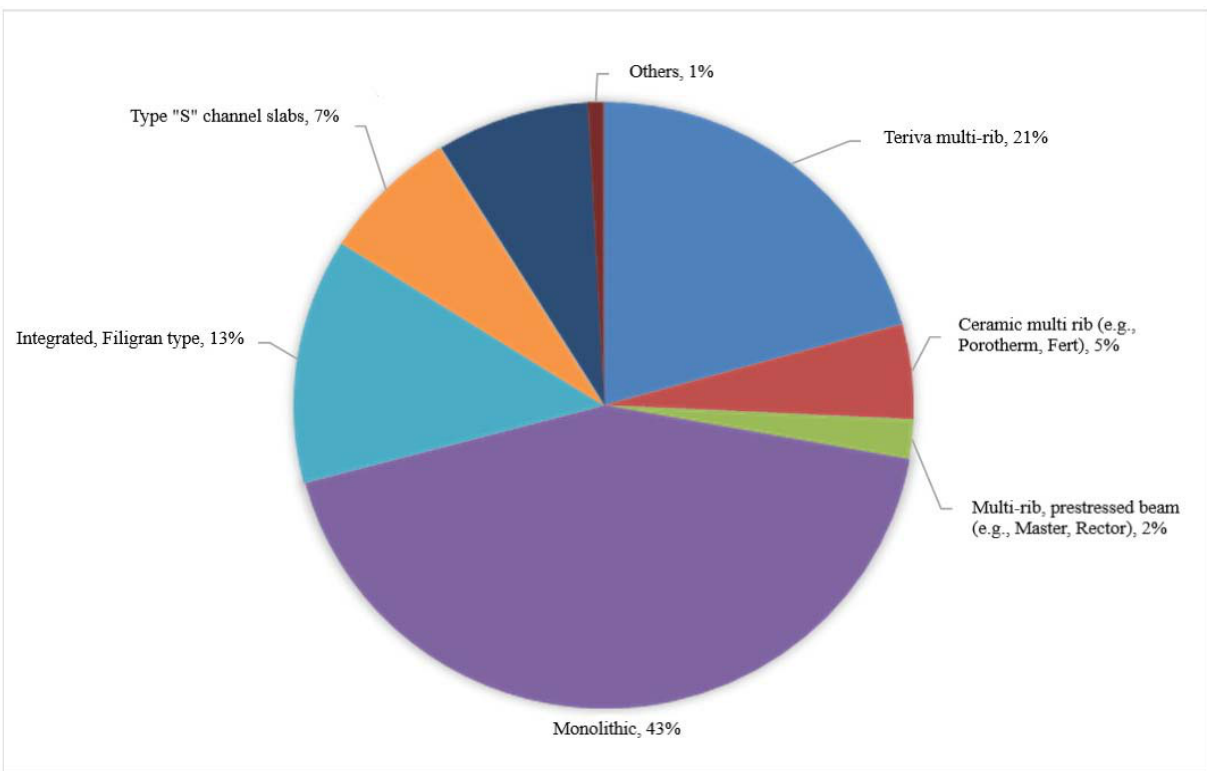
Fig. 4. The popularity of the flooring systems classified as “used very frequently” Source: Developed by the